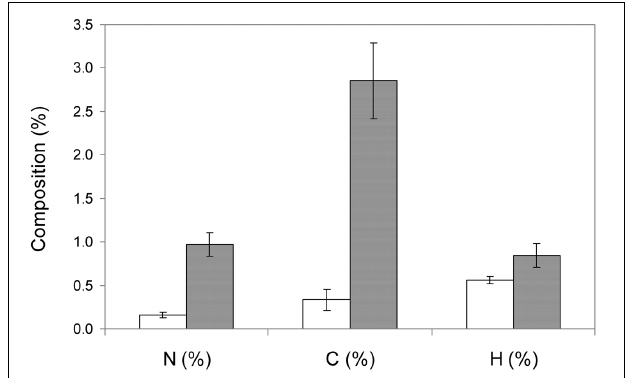
FIGURE 1 | Elemental analysis of naked MNPs (white bars) and MNP–NH 2 (gray